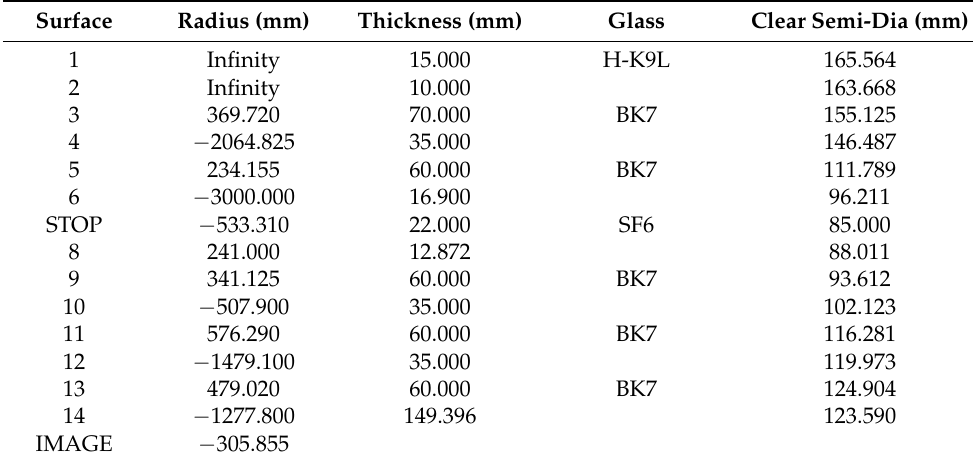
Table 1. The parameters of the new lens design.